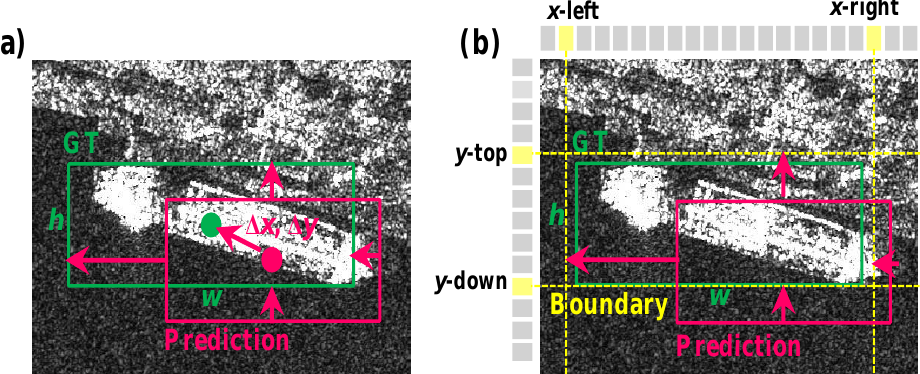
Figure 9. Different box prediction forms. ( a ) The traditional bounding box’s center offset (∆𝑥,∆𝑦) and the corresponding width and height offset (∆𝑤,∆ℎ) estimation. ( b ) The bounding box’s boundary estimation of this paper, which contains two basic steps, i.e., boundary prediction and location fine regression. The red colored box denotes prediction box. The green colored box denotes ground truth box. The green colored dot denotes the center of ground truth box. The red colored arrow denotes the trend of bounding box regression.